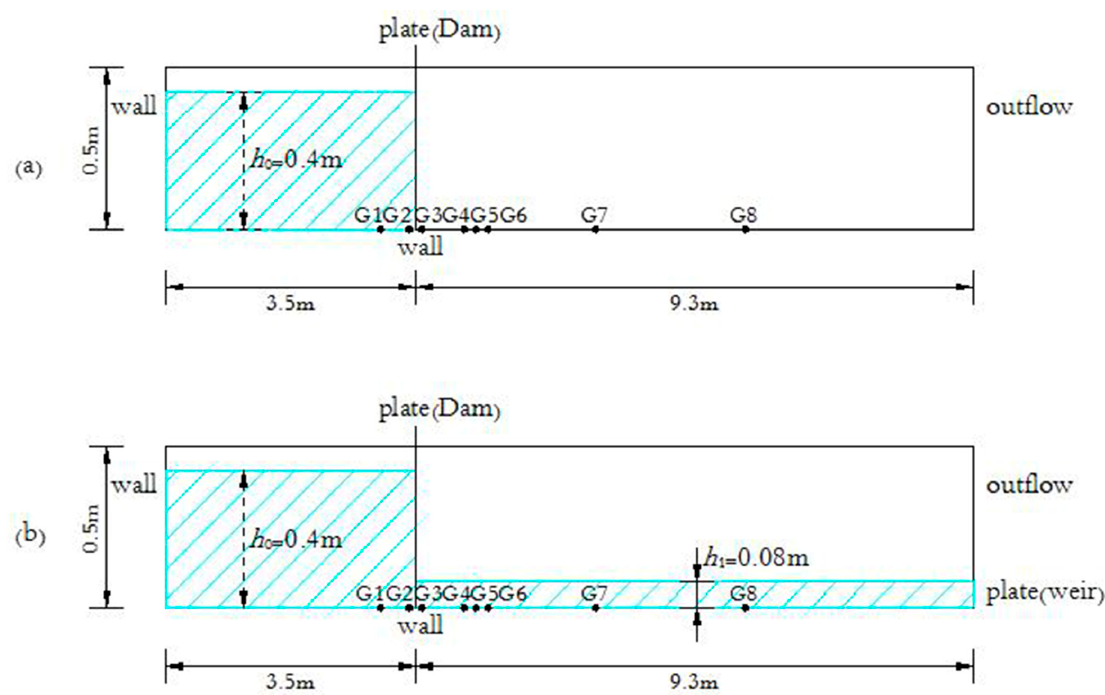
Figure 2. Schematic view of the experimental conditions by Khankandi et al. [39]: ( a ) α = 0 and ( b ) α = 0.2.